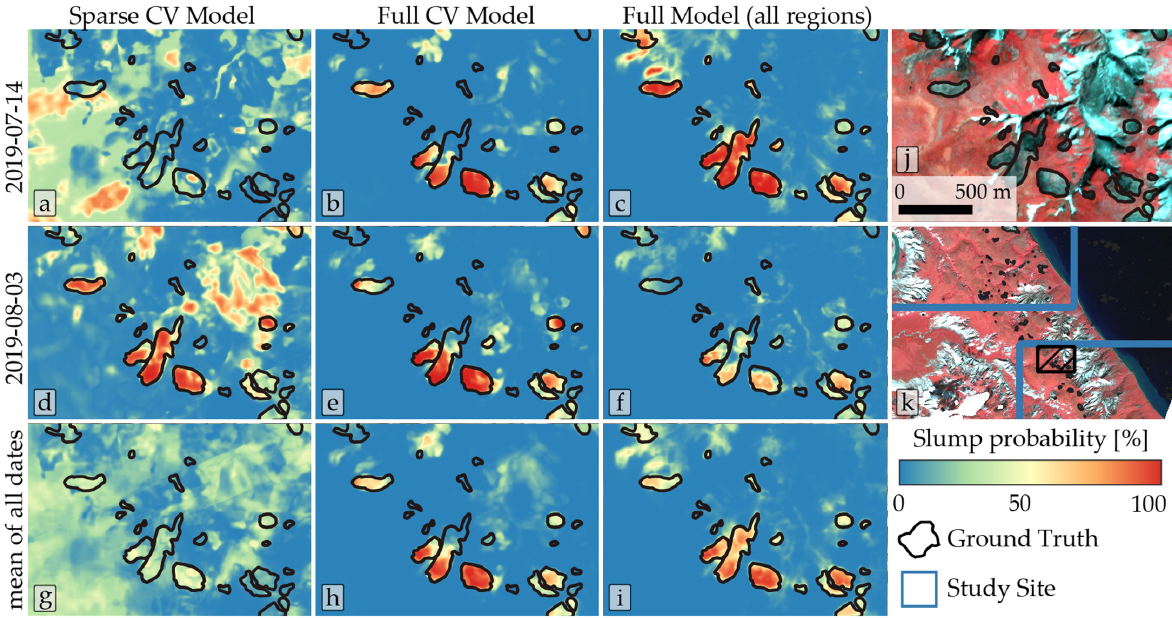
Figure 7. Detection results in the subset of the Horton Delta 02 study site with the modeled RTS probability on two different image dates (( a – c ): 14 July 2019; ( d – f ): 03 August 2019) and the mean of all dates ( g – i ) as well as three different models (( a , d , g ): sparse cross-validation model; ( b , e , h ): full cross-validation model; ( c , f , i ): full model trained on all regions). The subset of a multispectral false-color PlanetScope image (NIR-R-G) with ground truth is shown in panel ( j ). Panel ( k ) shows the approximate location of the subset within the study